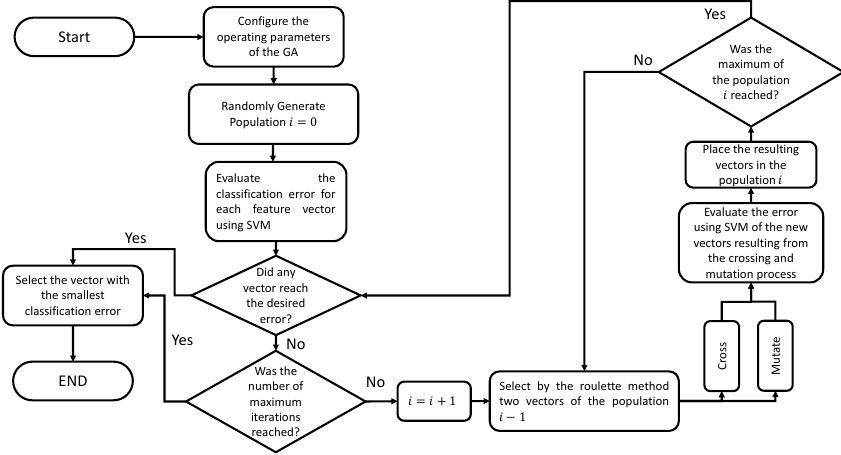
Figure 4. Flow chart for the integration of genetic algorithms and SVM for feature selection